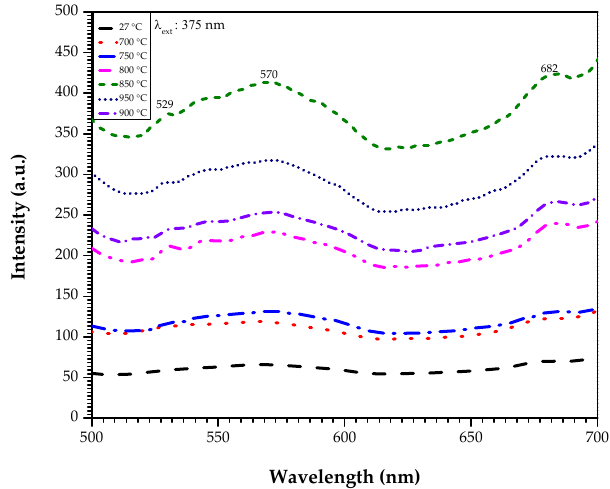
Figure 5. Emission spectra of the zinc silicate glass and glass-ceramics heat treated at various sintering temperatures. sintering